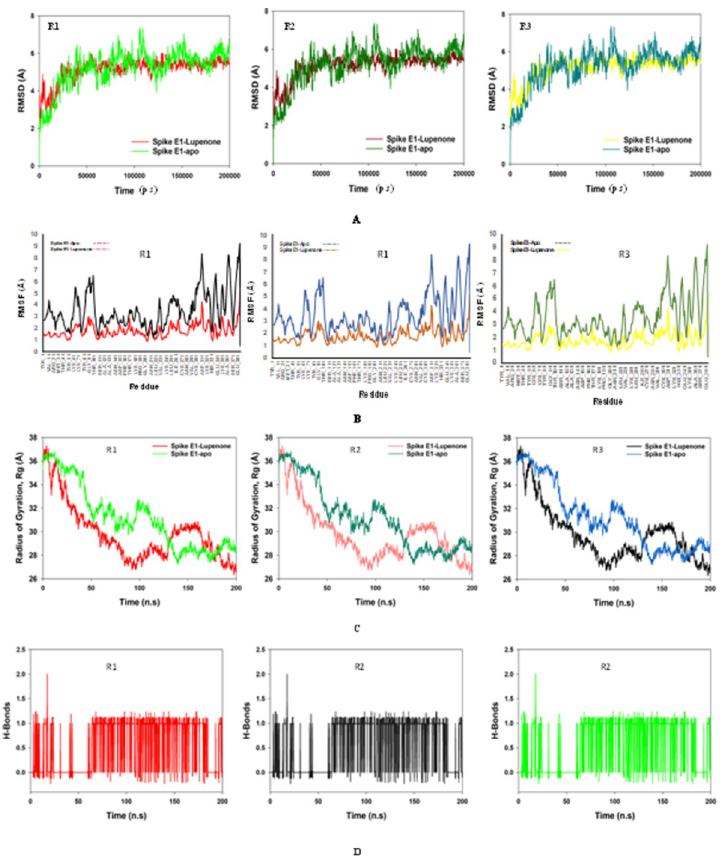
Fig 4. A . MD simulation trajectory analysis of Root Mean Square Divisions (RMSD) of 92158 (Lupenone) bound with 2ALA, i.e. Spike E1 200 ns time frame in triplicate displayed: R1 (replicate 1) RMSD plot of 92158 bound 2ALA (red) with control 2ALA (light green); R2 (replicate 2) RMSD plot of 92158 bound 2ALA (dark maroon) with control 2ALA (juniper green); R3 (replicate 3) RMSD plot of 92158 bound 2FLU (yellow) with control 2ALA (cyan); B . MD simulation trajectory analysis of Root Mean Square Fluctuations (RMSF) of 92158 (Lupenone) bound with 2ALA, i.e. Spike E1 200 ns time frame in triplicate displayed: R1 (replicate 1) RMSF plot of 92158 bound 2ALA (red) with control 2ALA (black); R2 (replicate 2) RMSF plot of 92158 bound 2ALA (maroon) with control 2ALA (cyan); R3 (replicate 3) RMSF plot of 92158 bound 2FLU (yellow) with control 2ALA (pickle green); C. MD simulation trajectory analysis of Radius of gyration (Rg) of 92158 (Lupenone) bound with 2ALA, i.e. Spike E1 200 ns time frame in triplicate displayed: R1 (replicate 1) Rg plot of 92158 bound 2ALA (red) with control 2ALA (light green); R2 (replicate 2) Rg plot of 92158 bound 2ALA (porcelain) with control 2ALA (dark green); R3 (replicate 3) Rg plot of 92158 bound 2FLU (black) with control 2ALA (Prussian blue); D. MD simulation trajectory analysis of Hydrogen Bonding (H-Bonds) of 92158 (Lupenone) bound with 2ALA, i.e. Spike E1 200 ns time frame in triplicate displayed: R1 (replicate 1) H-Bond plot of 92158 bound 2ALA (red); R2 (replicate 2) H-Bond plot of 92158 bound 2ALA (black); R3 (replicate 3) H-Bond plot of 92158 bound 2FLU (light